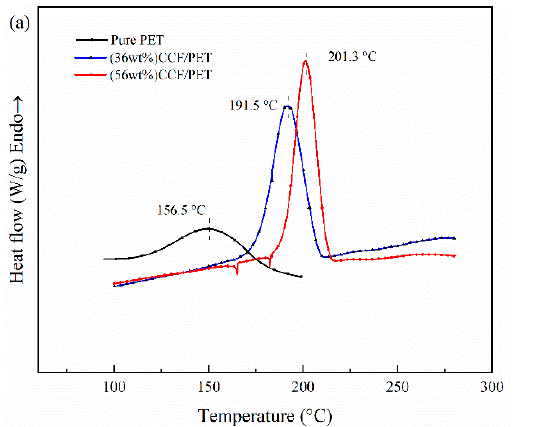
Figure 8. Crystallization behavior curves of pure PET, CCF/PET and CNT/CCF/PET composites: ( a ) pure PET, (36 wt%) CCF/PET, (56 wt%) CCF/PET, ( b ) (56 wt%) CCF/PET, (0.1 wt%) CNT/CCF/PET, (1.0 wt%) CNT/CCF/PET, (2.0 wt%) CNT/CCF/PET.